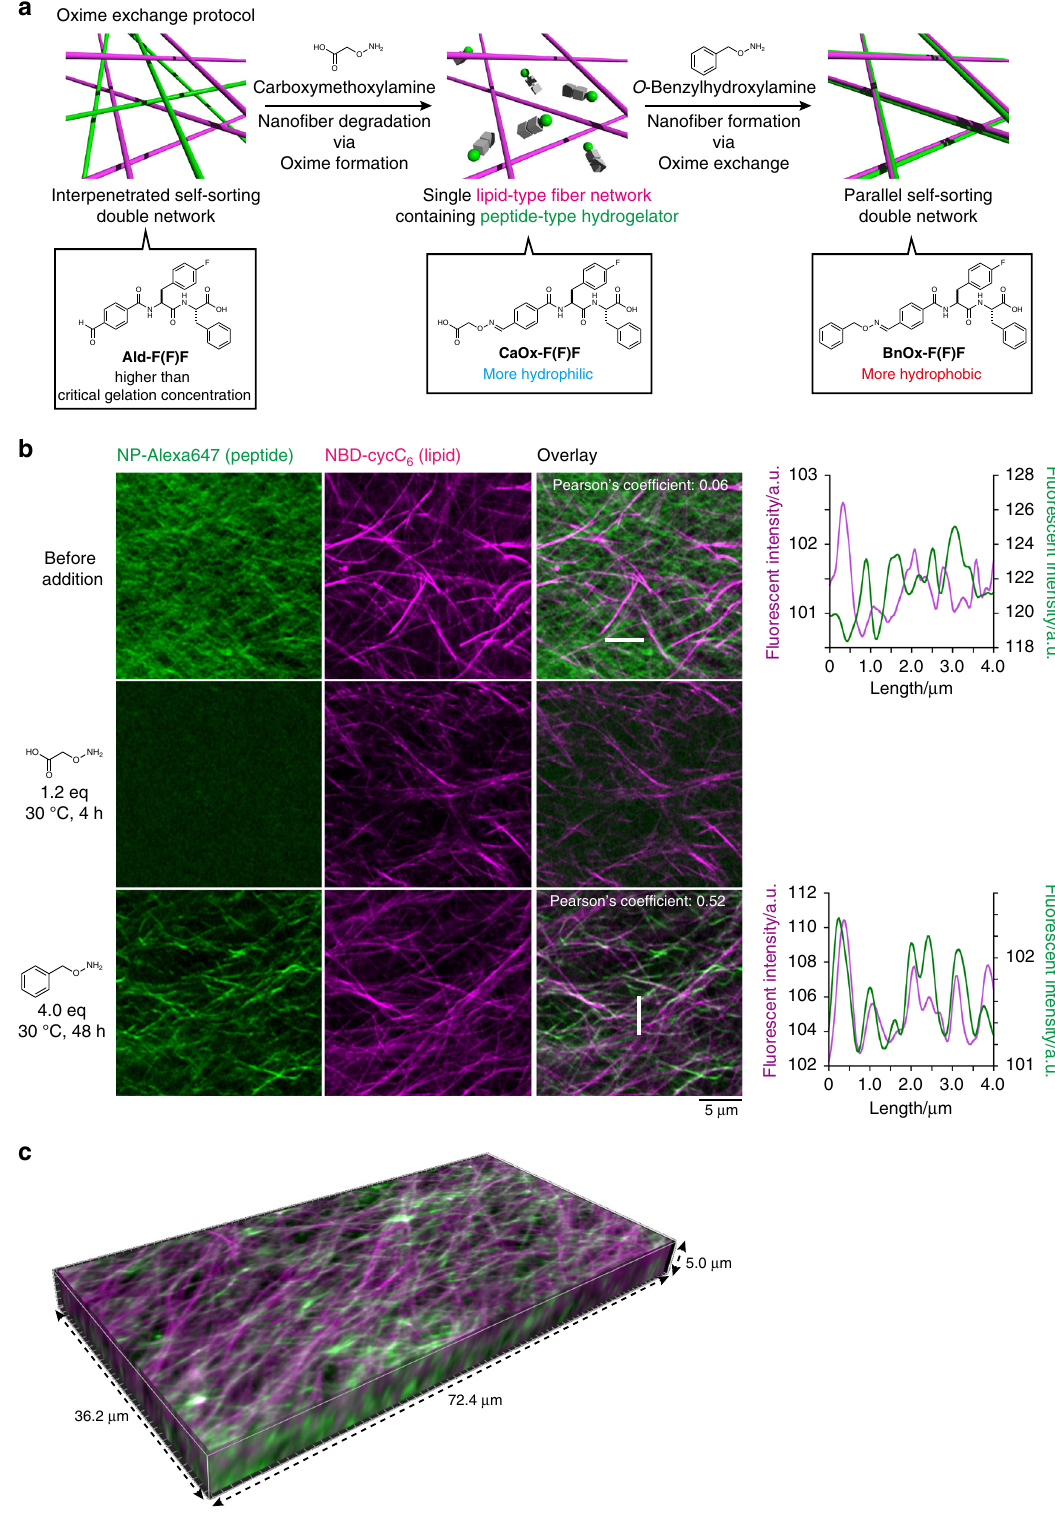
Fig. 5 Formation of the parallel self-sorting network through the oxime exchange protocol. a Schematic illustration of the transformation from the interpenetrated SDN to the parallel SDN by the oxime-exchange protocol. b High-resolution Airyscan CLSM images of (top) the interpenetrated SDN, (middle) the single lipid network, and (bottom) the parallel SDN. (Left) Alexa647 channel, (second column from the left) NBD channel, (third column from the left) overlay images, (right) line plot analyses along the white lines shown in the overlay images. c 3D Airyscan CLSM imaging of the parallel SDN. Green: NP-Alexa647 , magenta: NBD-cycC 6 . Condition: [ Ald-F(F)F ] = 17.3 mM (0.80 wt%), [ Phos-MecycC 5 ] = 2.4 mM (0.15 wt%), [carboxymethoxylamine] = 20.8 mM (1.2 eq), [ O -benzylhydroxylamine] = 69.2 mM (4.0 eq), [ NP-Alexa647 ] = 4.0 µ M, [ NBD-cycC 6 ] = 4.0 µ M, 100 mM MES, pH 6.0, 30